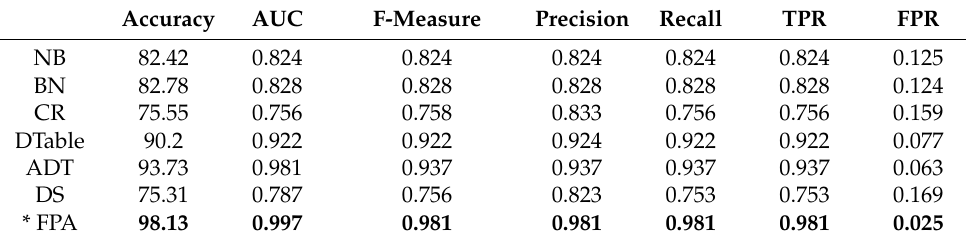
Table 7. Detection performances of FPA and baseline classifiers on the Drebin dataset.